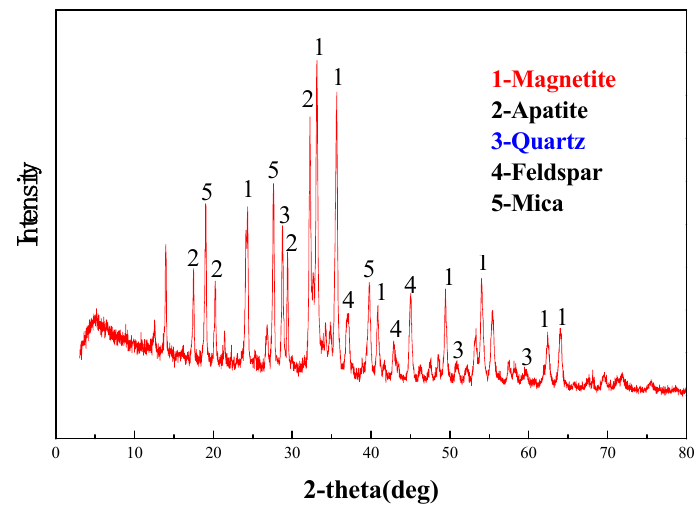
ff raction phase analysis of oolitic iron ore Figure 1. X-ray diffraction phase analysis of oolitic iron ore sample. Figure 1. X-ray di